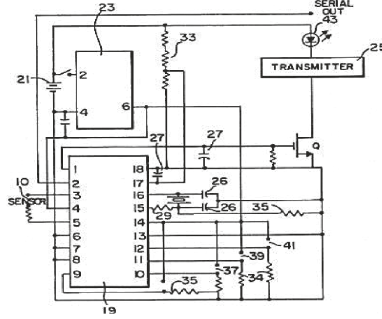
Figure 4: Patented on motion